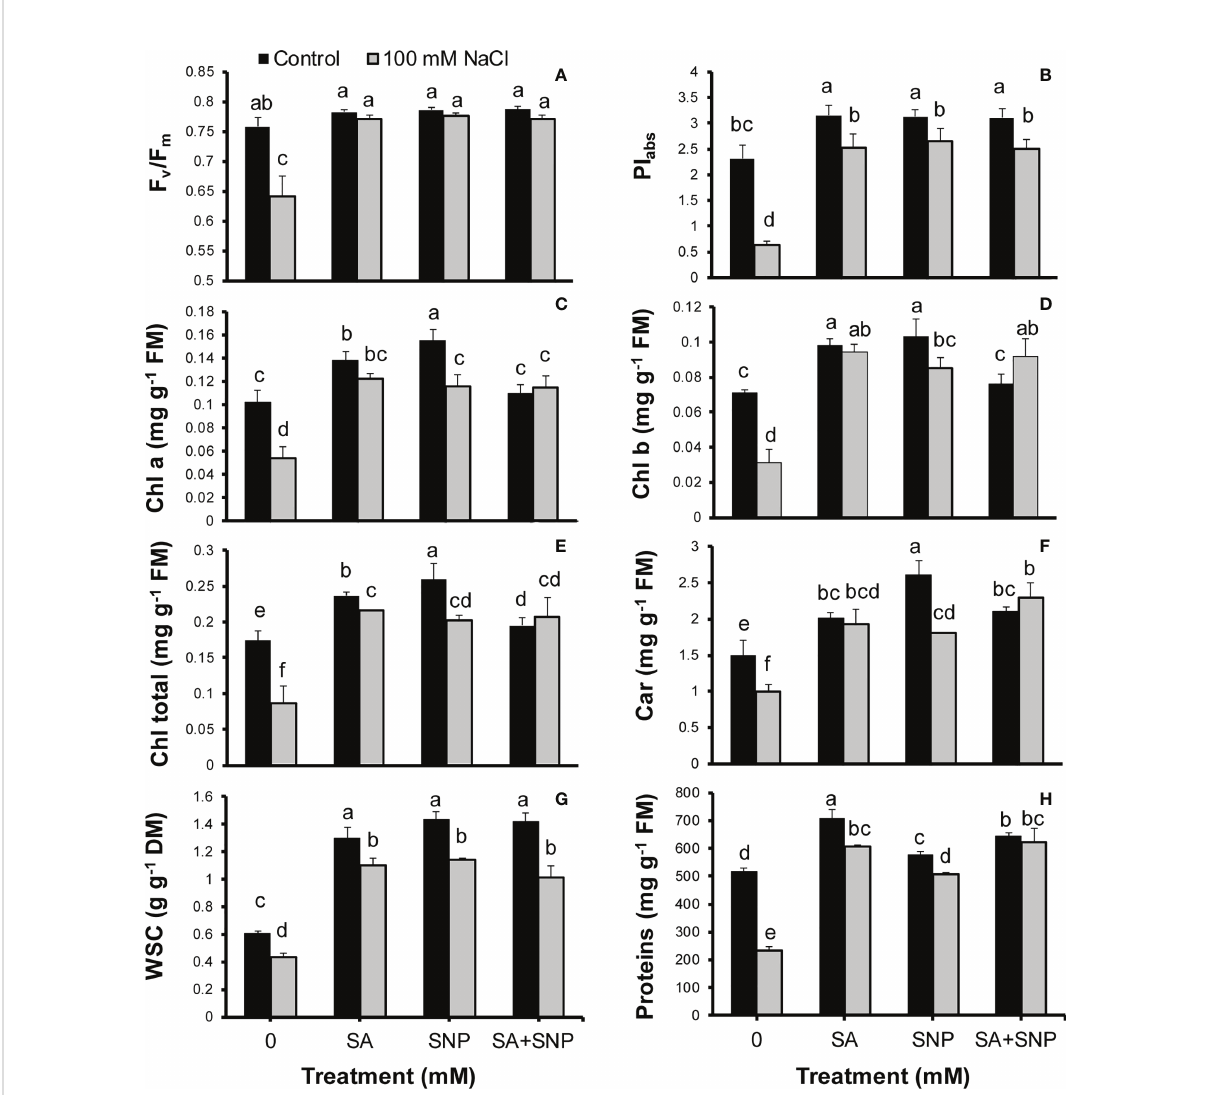
FIGURE 4 (A) Maximum quantum yield of photosystem II (F v /F m ), (B) ef fi ciency of both photosystems I and II (PI abs ), (C) chlorophyll a (Chl a), (D) Chl b, (E) total Chls, (F) carotenoids, (G) water soluble carbohydrate (WSC), and (H) proteins in Chenopodium quinoa under different treatments of salicylic acid (SA) and sodium nitroprusside (SNP), and salinity stress. Columns with different letters are signi fi cantly different at p <